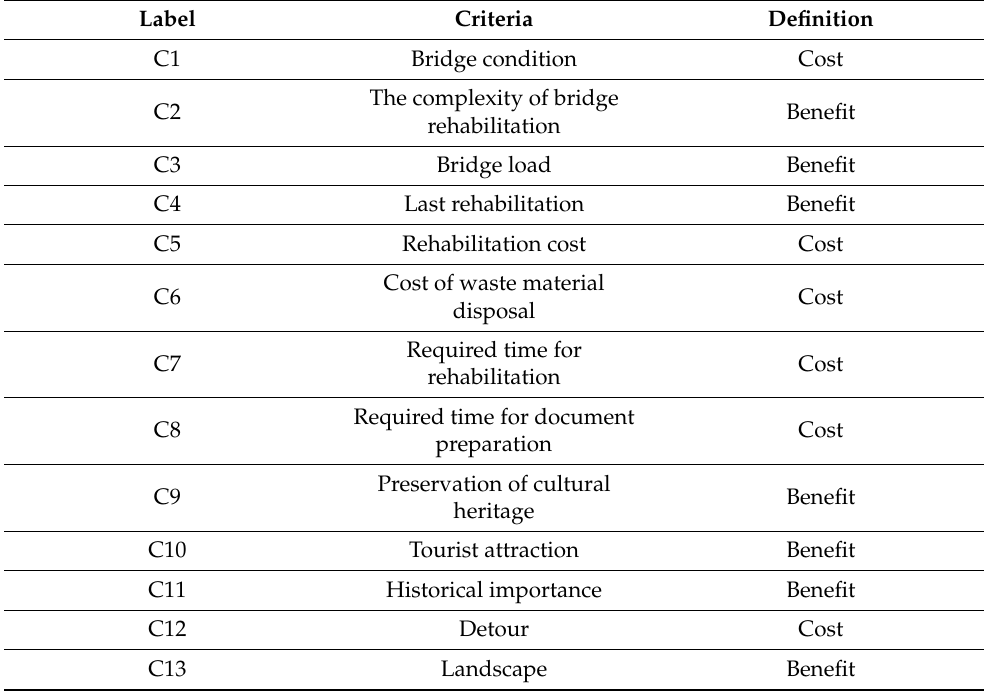
Table 1. List of criteria with definition.